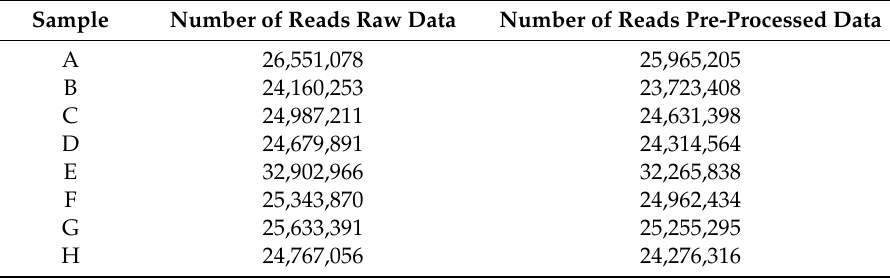
Table A1. Number of reads for raw and pre-processed